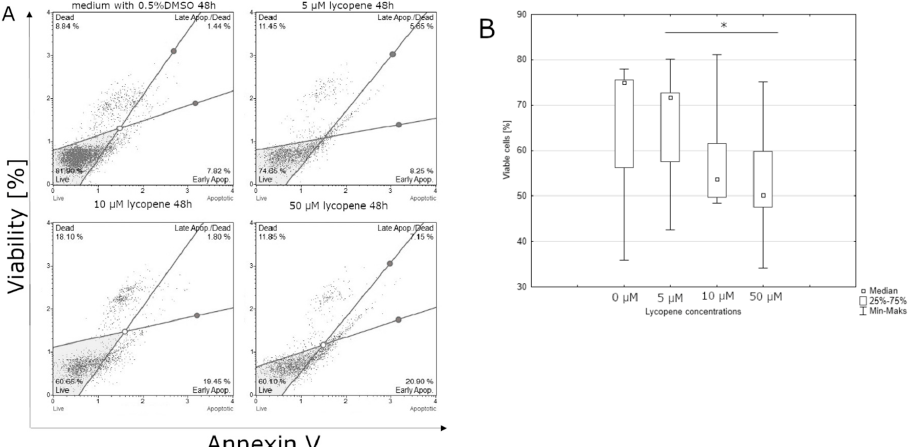
Figure 2. ( A ) lycopene induces apoptosis in the U-118MG cells. Cells were treated with DMSO or various concentrations of lycopene for 48 h. Adherent cells were collected and stained with Annexin V and 7-AAD and events for early apoptotic cells were counted with the Muse Cell Analyzer; ( B ) e ff ect of the indicated concentrations of lycopene on U-118MG apoptosis after 48 h incubation using Annexin V staining. The representative experiment is a median and di ff erence between lycopene concentration and the control evaluated using ANOVA Friedman p = 0.02 and post-hoc tests * p <